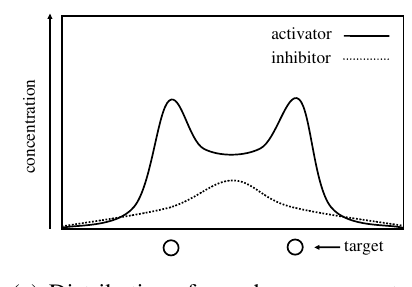
Figure 4 . Distribution of u , v , and u=